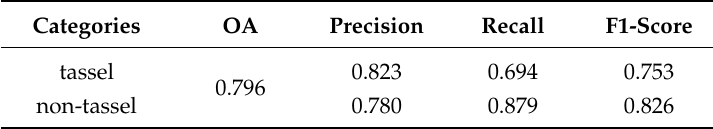
Table 4. The result of RF in fine detection of